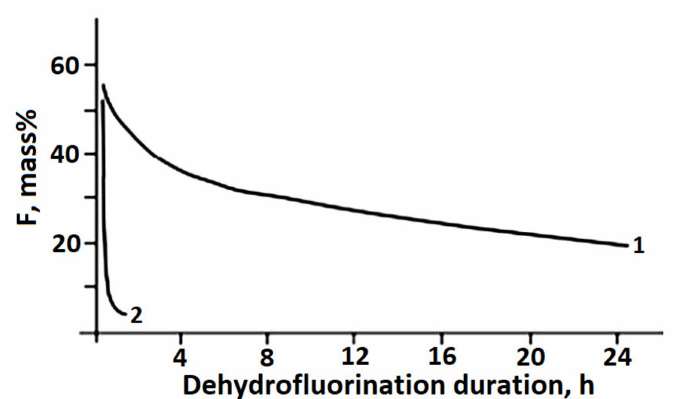
Figure 12. Dependence of the residual fluorine content in PVDF films on the DHF time during the reaction in an argon flow at (1) 22 and (2) 68 ◦ C